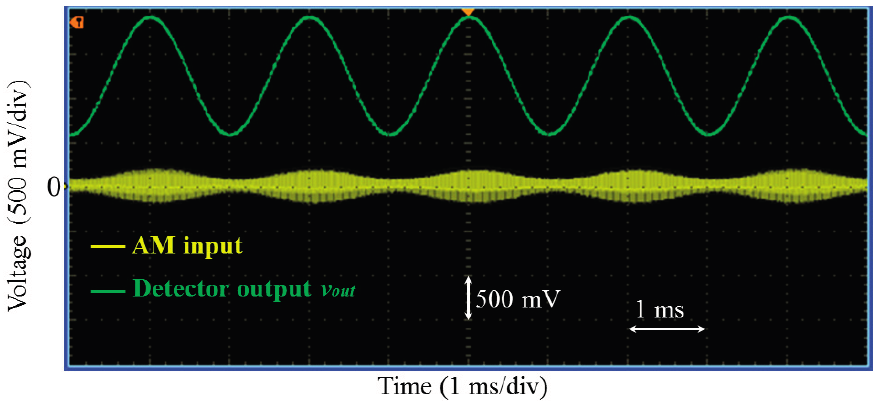
Figure 11. Demodulation of AM signals. The frequencies of the carrier and of the modulating signals were about 1 MHz and 400 Hz,